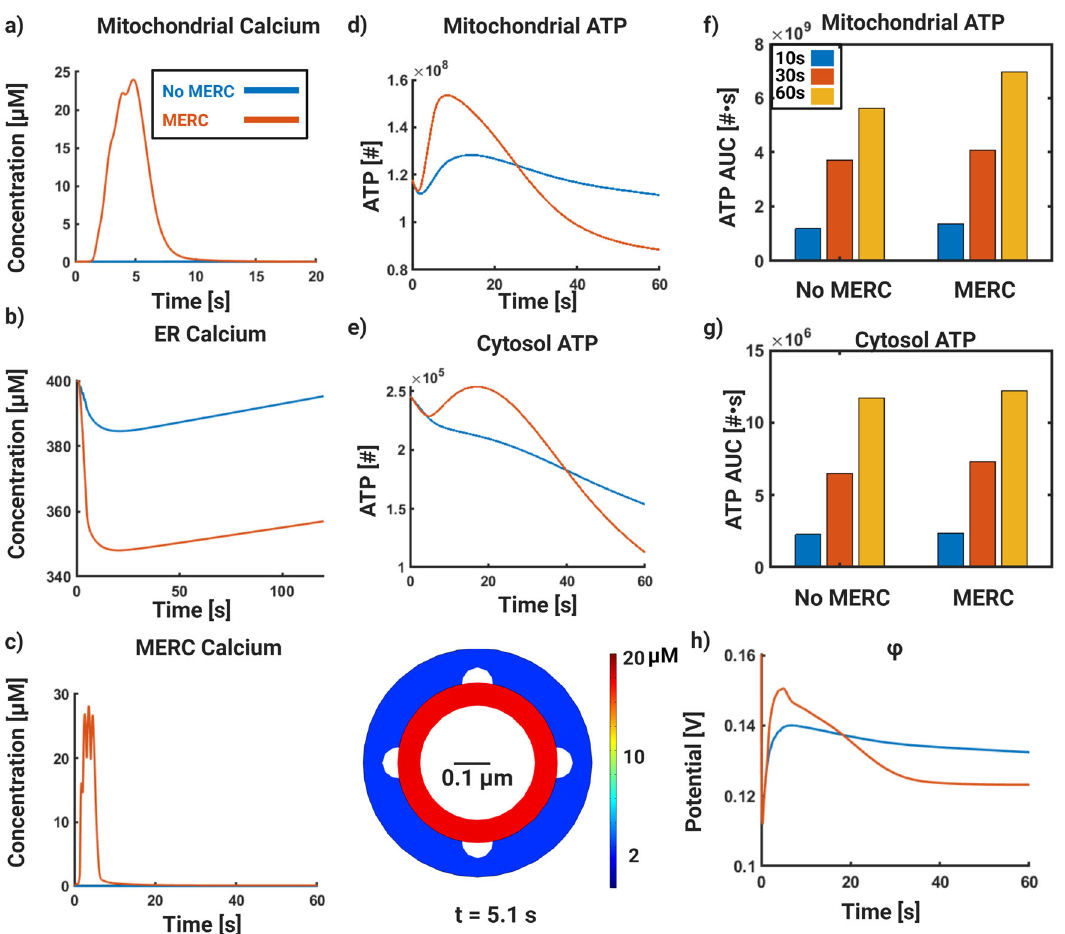
Fig. 3 Receptor-based simulations of glutamatergic signaling in spatial calcium model. Finite element simulations of dendritic spines including mitochondria, ER, and mitochondrial-ER contacts(MERC). a ) Mitochondrial Ca 2 + dynamics in the presence of (red) and absence of (blue) MERC. b ) ER Ca 2 + dynamics in the presence of (red) and absence of (blue) MERC. c ) Dynamics of MERC Ca 2 + in the MERC case only (left); cross-section of MERC ring showing a higher concentration of Ca 2 + in the MERC ring as opposed to the general cytoplasm (right). d ) Mitochondrial ATP dynamics in the presence of (red) and absence of (blue) MERC. e ) Cytosolic ATP dynamics in the presence of (red) and absence of (blue) MERC. f ) AUC for mitochondrial ATP at 10 (blue), 30 (red), and 60 s (yellow) with and without MERC. g ) AUC for cytosolic ATP at 10 (blue), 30 (red), and 60 s (yellow) with and without MERC. h ) Mitochondrial membrane potential in the presence of (red) and absence of (blue)